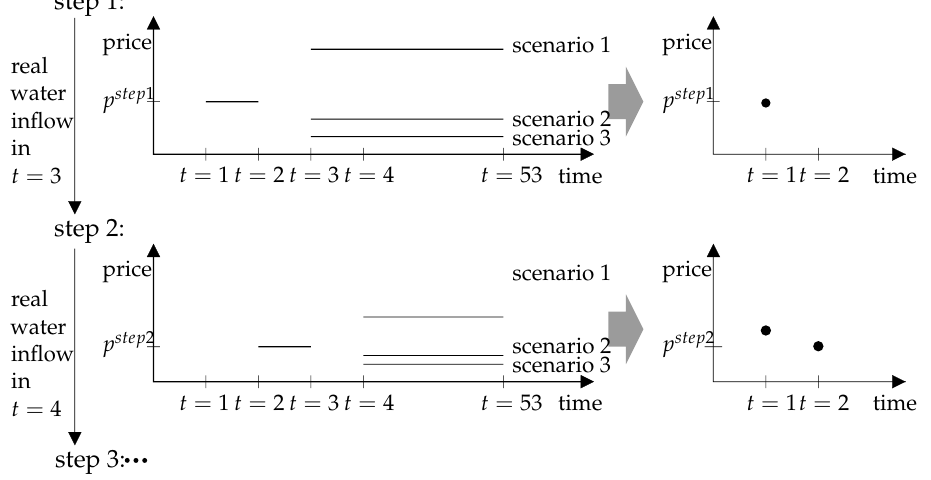
Figure 4. Example: price building in a stochastic optimisation